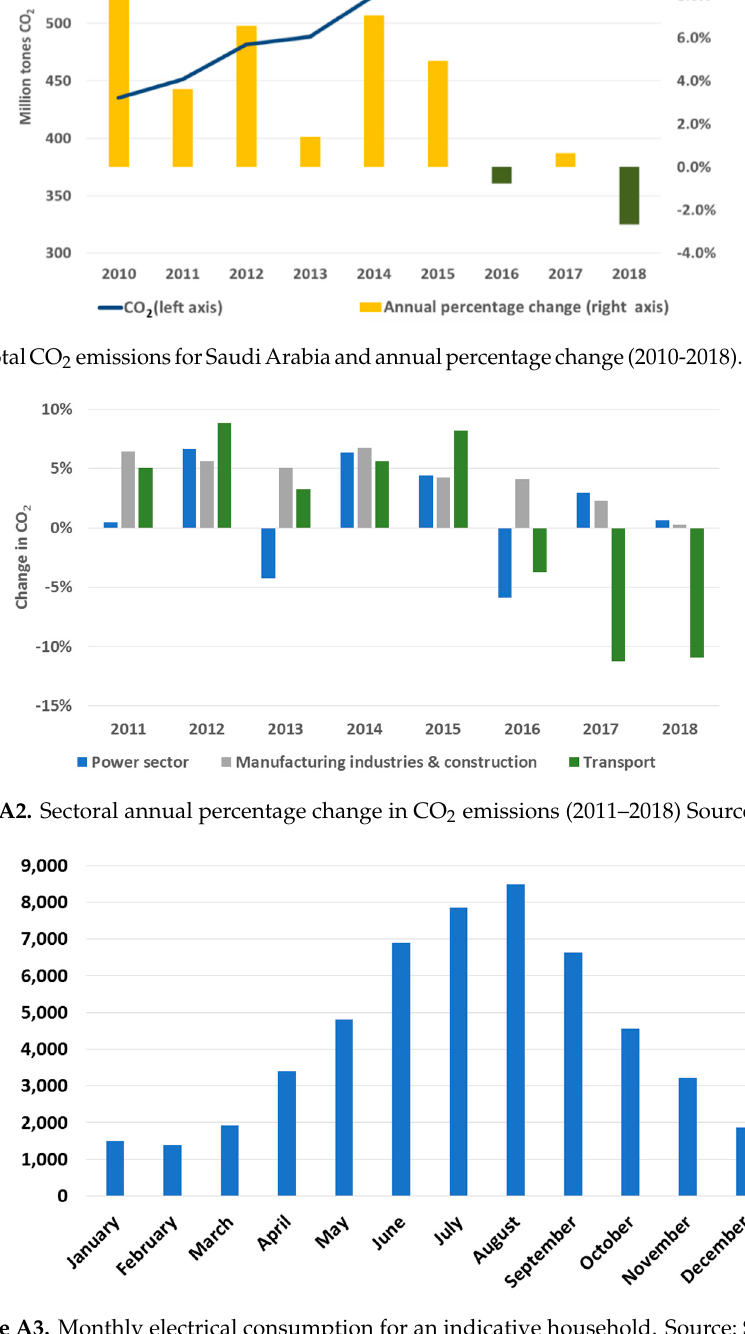
Figure A3. Monthly electrical consumption for an indicative household. Source: SEC.